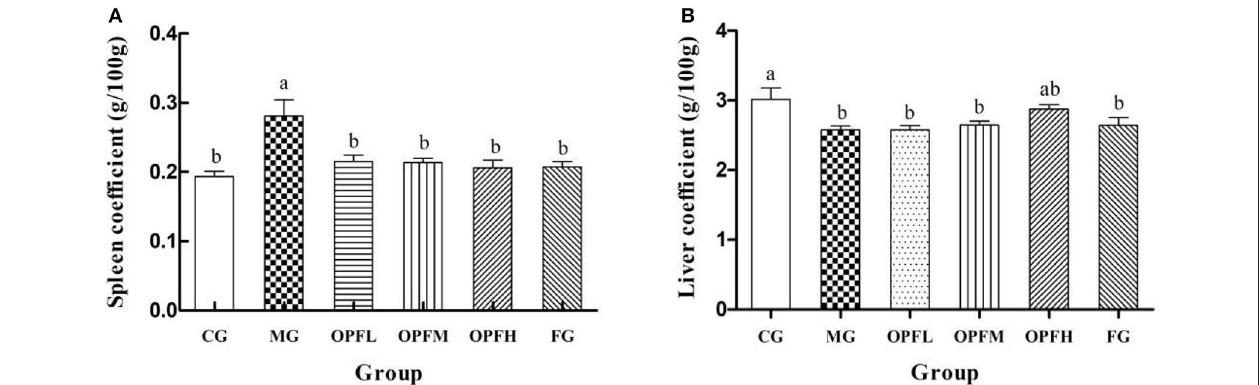
FIGURE 4 | Effects of different doses of OP-Fe 2 + and FeCl 2 on (A) spleen coefficient and (B) liver coefficient in IDA rats. Data are presented as mean ± SD ( n = 10). The presence of two different letters in two groups indicate a statistical difference ( p < 0.05) between them; the same letter in two different groups indicates the absence of a statistical difference between these two